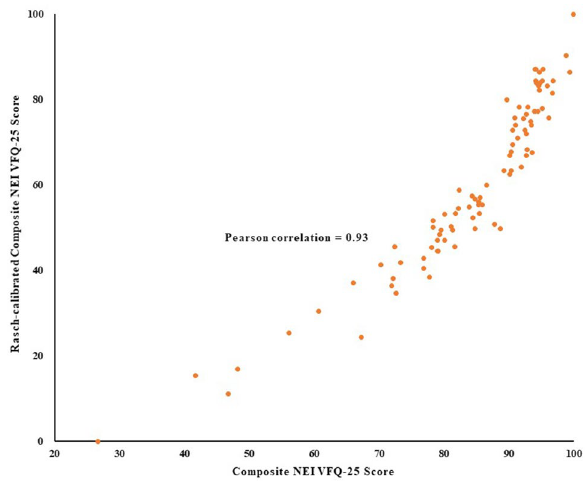
Figure 1. The relationship between original NEI VFQ-25 composite score and Rasch-calibrated NEI VFQ-25 composite